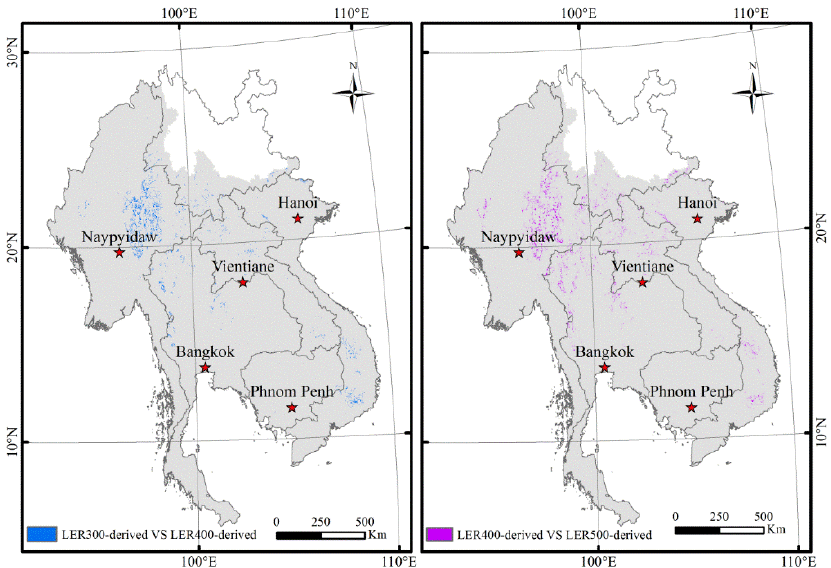
Figure 7. Maps showing the differences of between the reasonable estimation (LER400 derived) and the optimistic and conservative estimates, namely LER300 derived and LER500 derived, respectively. Table 4. Accuracy assessment of the OLI-derived swidden agriculture landscape maps in this study. Total No. of Ground Reference Pixels Producer’s Class Total No. of Classified Pixels